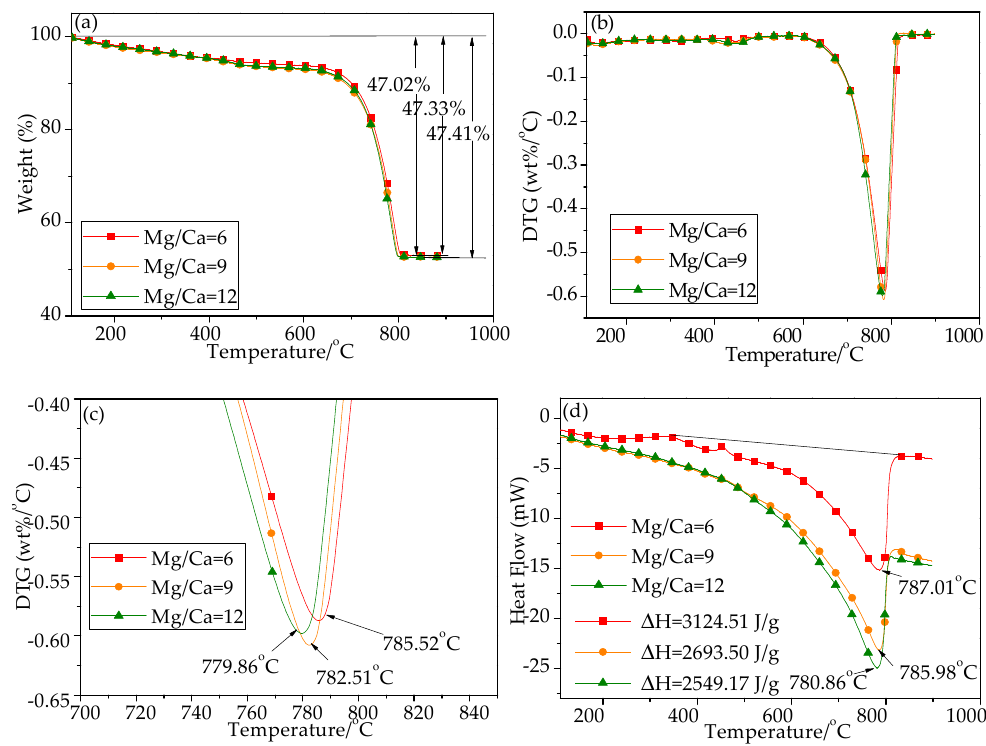
Figure 7. Thermogravimetry (TG) ( a ), differential thermogravimetry (DTG) ( b and c ), and differential scanning calorimetry (DSC) ( d ) analyses of the mineral precipitates cultured for 14 days. 3.4. HRTEM and SAED Analyses of Ultra-Thin Slices of B. subtilis J2 Bacteria